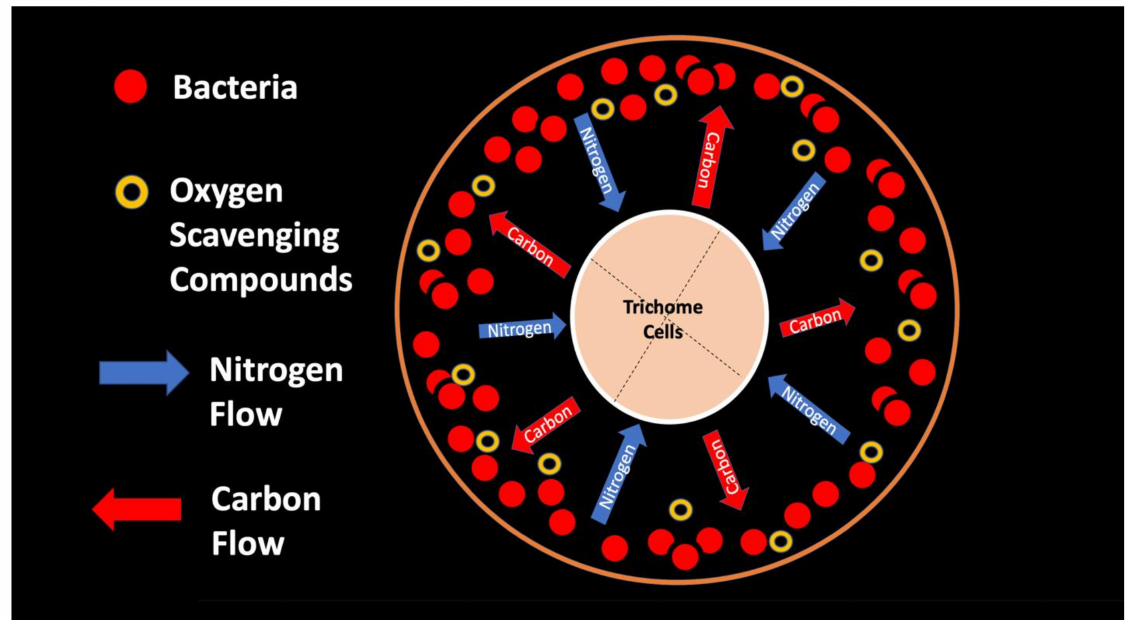
Figure 17. Suggested model of nitrogen transfer in glandular trichomes of Cannabis sativa : Carbon (sugars), produced by photosynthetic trichome stalk cells that bear the trichome head, are secreted (red arrows) from the central trichome cells (tan color) onto bacteria (red color). This stimulates growth and fuels nitrogen fixation by bacteria in the trichome. Trichome cells also secrete oxygen- scavenging compounds (yellow rings; e.g., cannabinoids) to scavenge atmospheric oxygen and reduce the inhibition of nitrogenase by oxygen. Trichome cells harvest nitrogen from bacteria by secreting superoxide onto bacteria, causing them to form wall-less protoplasts (L-forms) and stimulating them to secrete antioxidant nitric oxide (blue arrows), which combines with superoxide to form nitrate that may be absorbed by the central trichome